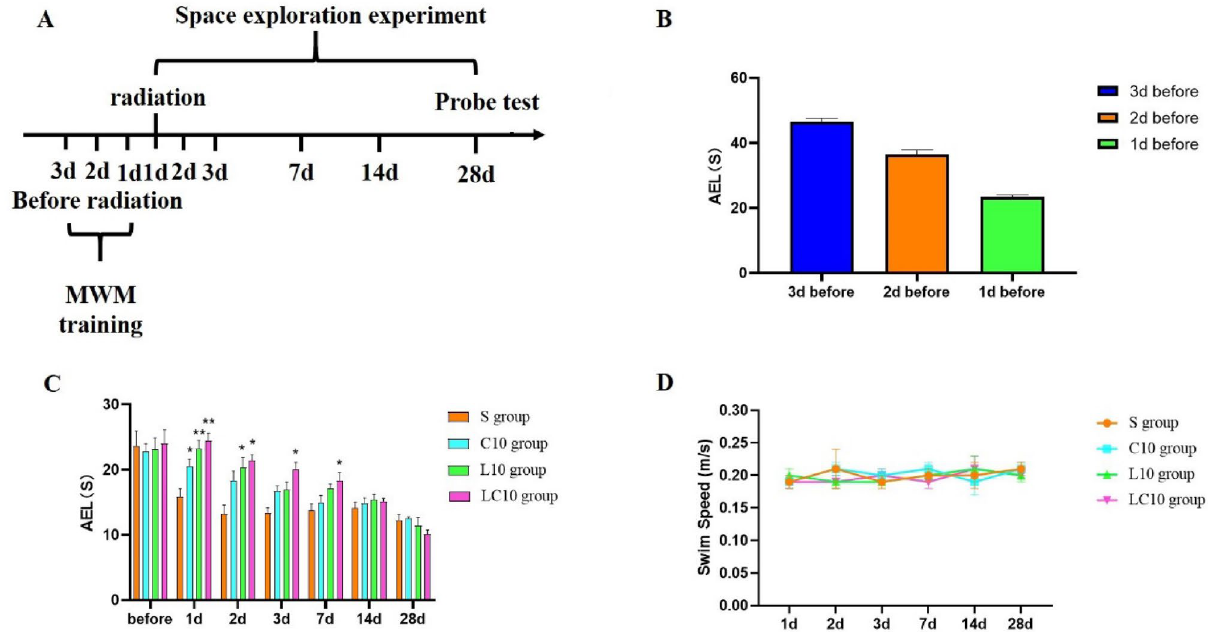
Figure 2. Analysis of the results of the water maze experiment in rats. ( A ) Morris Water Maze experiment process. ( B ) water maze AEL of 3 days before radiation in rats. ( C ) Changes in the water maze AEL values of rats before and 1–28 days after microwave irradiation. ( D ) Changes in the swimming speeds of rats in the water maze from 1 to 28 days after microwave irradiation. Quantized data are shown as the mean ± SE. *P < 0.05, **P < 0.01, vs. sham. B , C and days were drawn by Graph Pad Prism 6 and the data were analyzed by SPSS